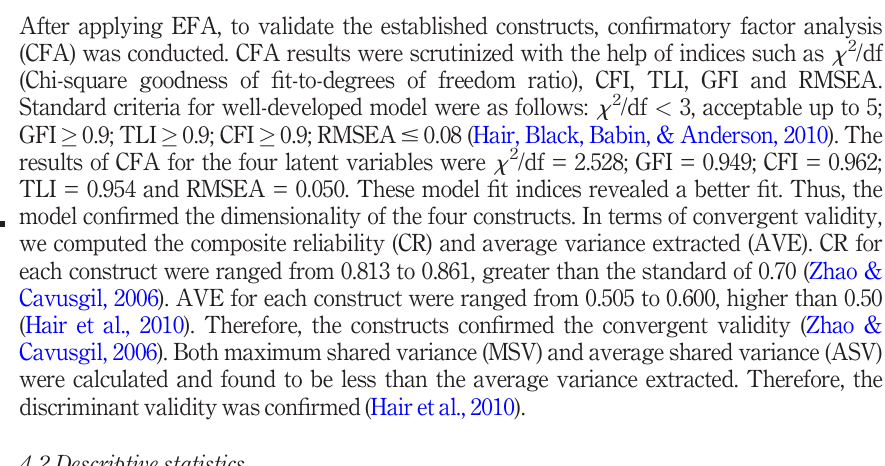
intrinsic motivation ( b = 0.491***, p # 0.001) and job involvement ( b = 0.500***,